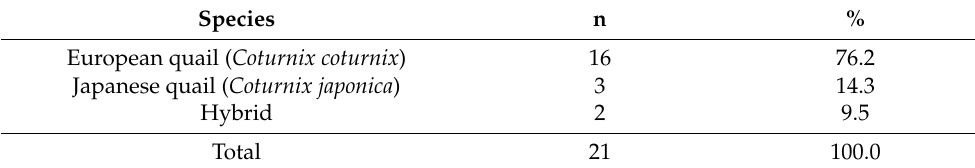
Table 4. Frequency and percentage of game farms that raised certain genetic types of